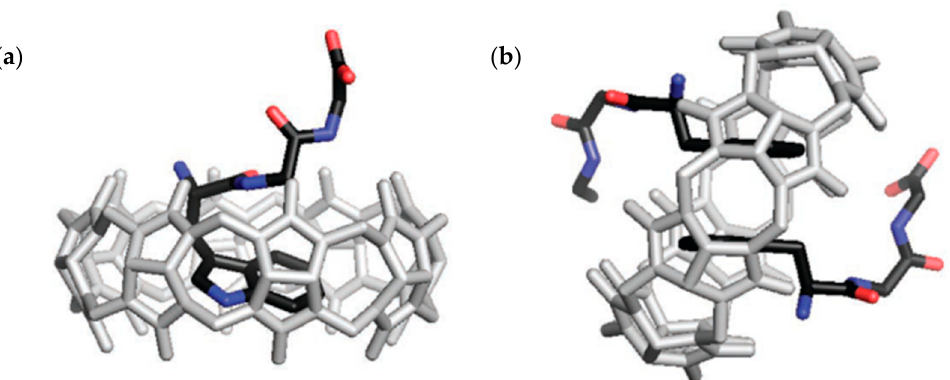
Figure 20. Crystal structure of the complexes with CB8 (structure in white) and the peptides (structures in black)—( a ) CB8- (Trp-Gly-Gly) and ( b ) CB8-(Phe-Gly-Gly)2. Despite the formation of 1:2 complexes for both these peptides, Heitmann et al. were only able to obtain this complex structure for Phe-Gly-Gly. Reprinted with permission from [108]. Copyright (2006) American Chemical Society.